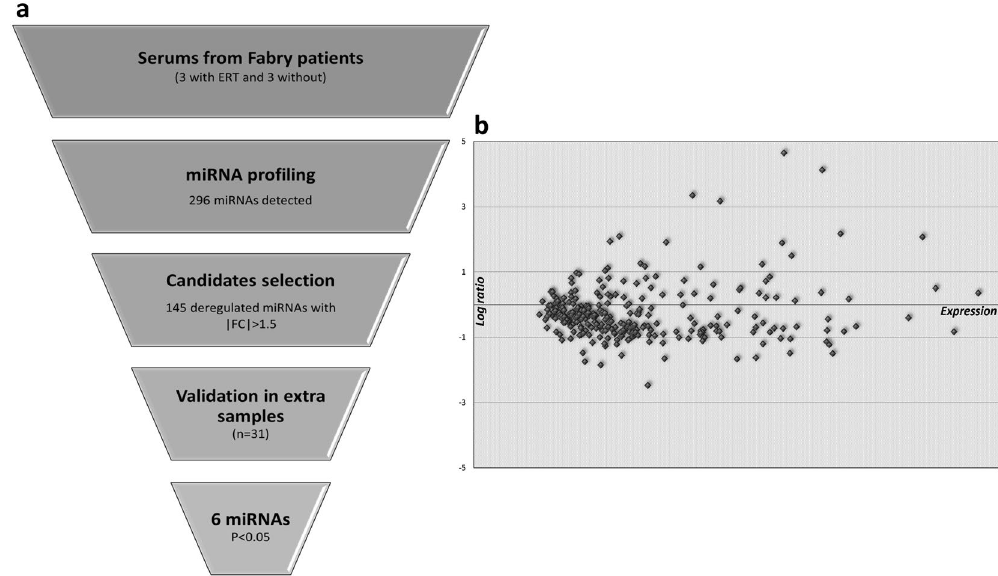
Figure 1. Screening strategy and the global expression pattern of miRNAs in the serum of Fabry patients. ( a ) Schematic strategy for identification and validation of the deregulated miRNAs. ( b ) The MA-plot illustrates the log transformed fold change (y-axis) of miRNA expression between patients with and without ERT versus normalized expression level (x-axis) of the 296 miRNAs detected by global